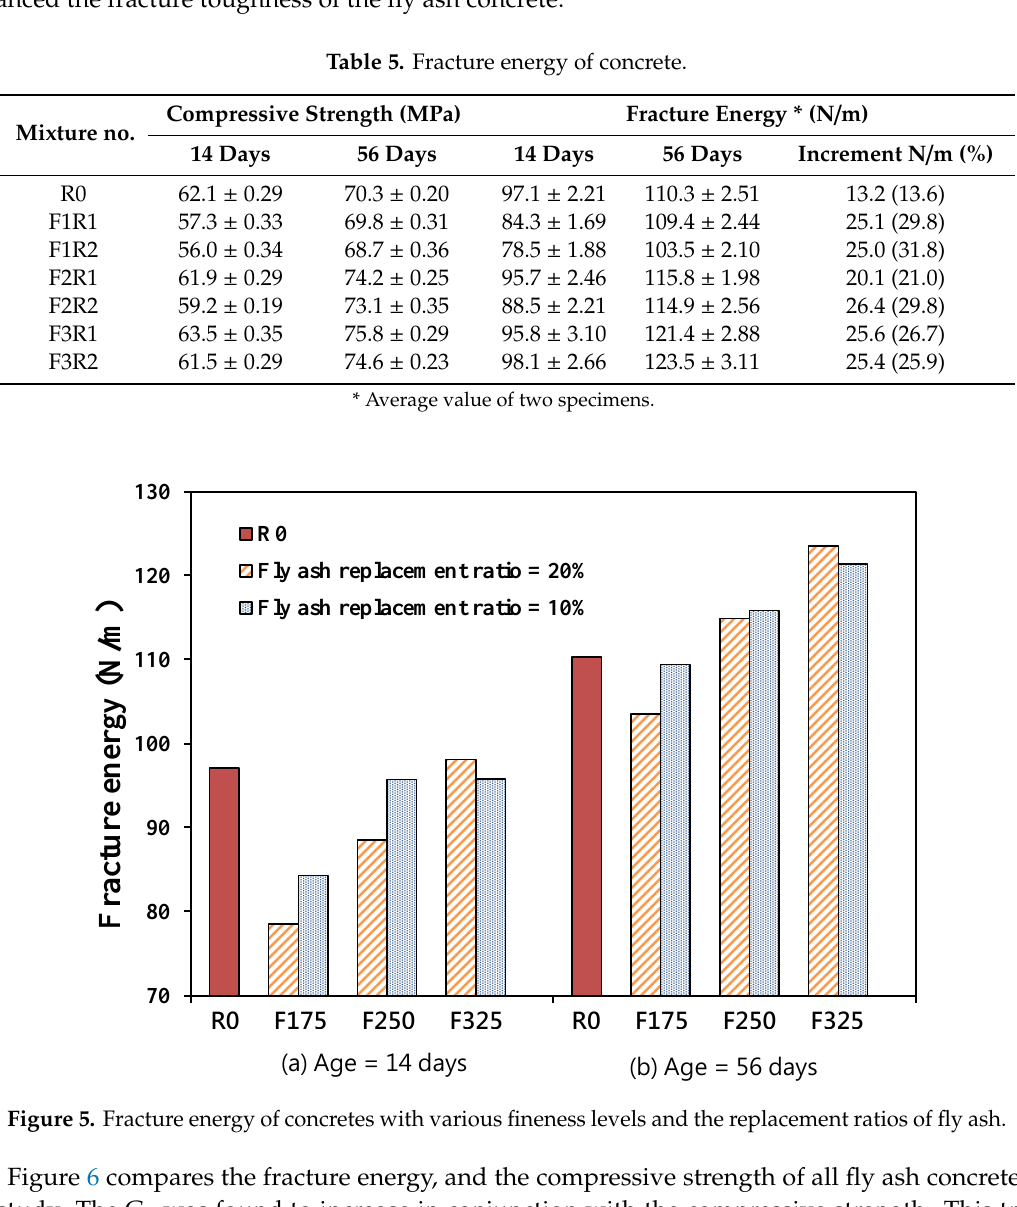
Table 5. Fracture energy of concrete.